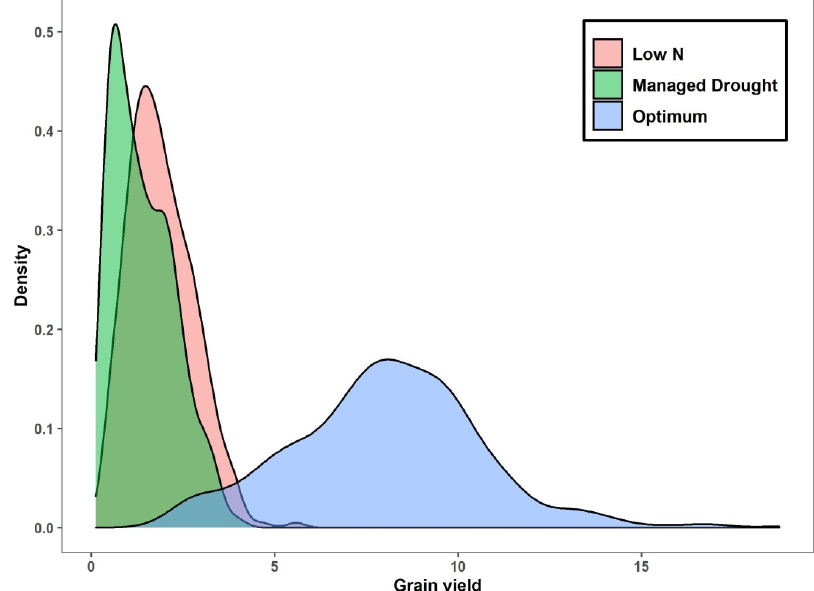
Figure 1. Density plot for grain yield (t ha − 1 ) performance of test hybrids under optimum, low nitrogen and managed drought conditions. The area under the curve represents the probability of getting hybrids with certain grain yield performance along the x-axis.